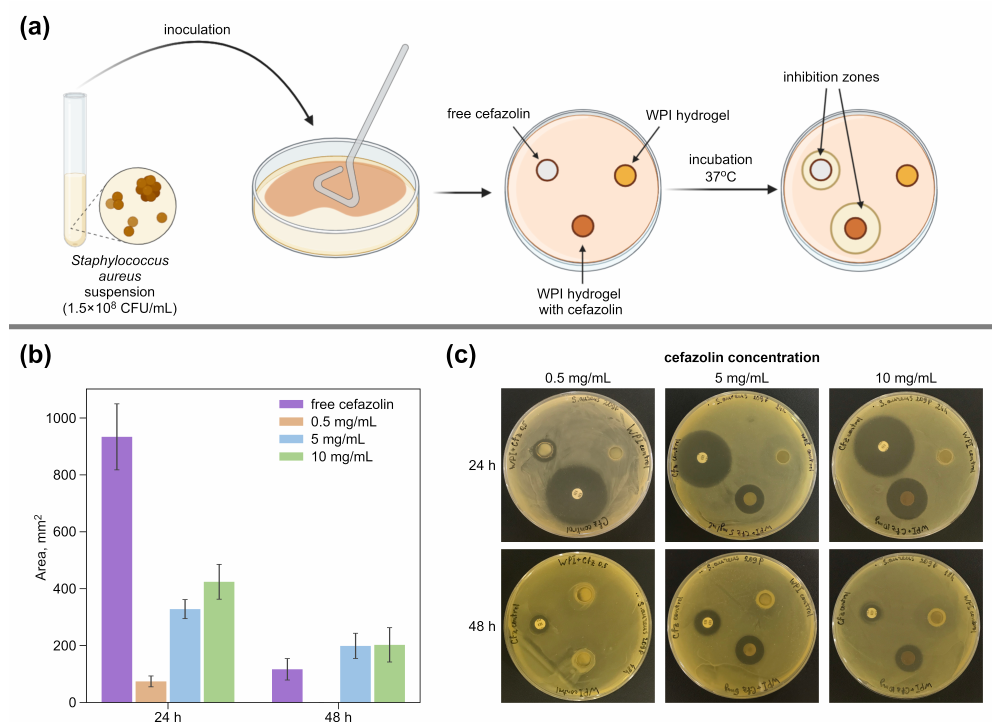
Figure 2. ( a ) The principal scheme of the experiment to study the antibacterial activity of WPI- based hydrogels with different cefazolin concentrations on dense nutrient media against S. aureus . ( b ) Average growth inhibition zone sizes and ( c ) visualization of S. aureus bacterial strains during study of an antimicrobial action of WPI-based hydrogels containing cefazolin, cefazolin standard disk (control), WPI-hydrogel (0 mg/mL of cefazolin) by agar diffusion method. Values are presented as means ± standard deviations ( n =